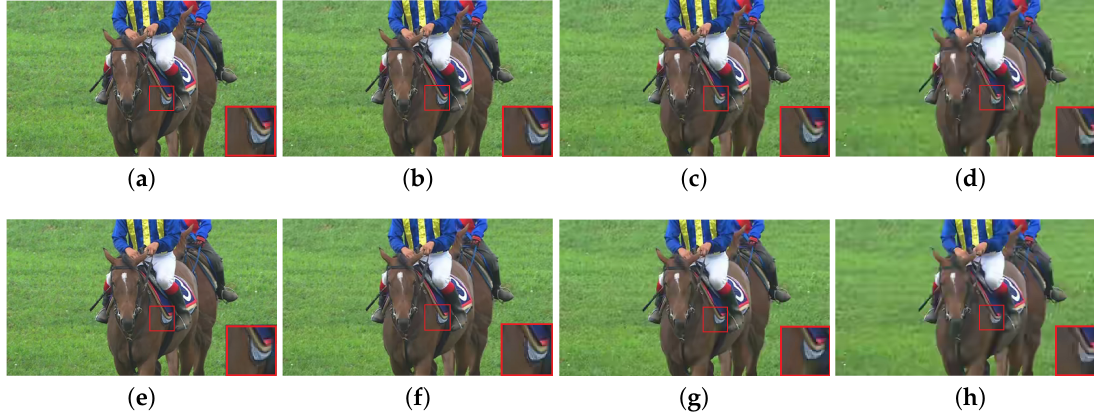
Figure 16. Visual quality comparison of videos encoded with different Quantization Parameter (QPs) by the original HM16.7 and the encoder in which the proposed ABTFA with BD-rate loss constraint 0.9% is applied. ( a – d ) the 150-th frame of video sequence RaceHorses (416 × 240) which is encoded by the original HM16.7 under QPs 22, 27, 32, 37, respectively. ( e – h ) the 150-th frame of video sequence RaceHorses (416 × 240) which is encoded by the proposed ABTFA with BD-rate loss constraint 0.9% under QPs 22, 27, 32, 37, respectively. We zoom in the block with red boundary in the middle of each sub-picture to observe the details. The details can be observed from the block with red boundary locating at the bottom-right corner in each